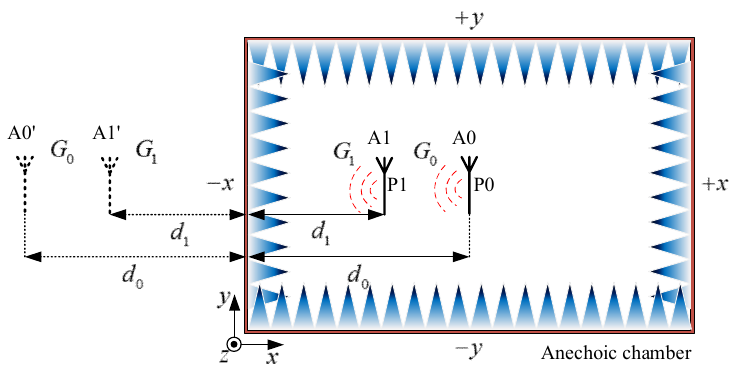
Figure 3. Different measurement positions of directional antennas.